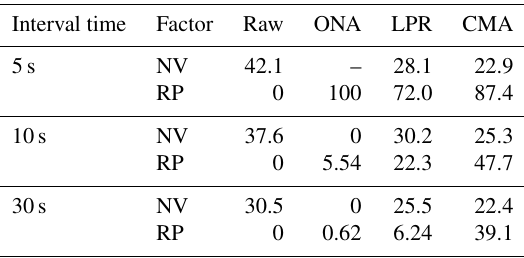
Table 2. The proportion of negative value (NV) and average reduction of peak (RP) samples under the different post-processing methods (values are shown in percent; NV [%]: proportion of negative values remaining; RP [%]: average reduction of peak samples. Symbol “–” means no data; measurements 1–10). Interval